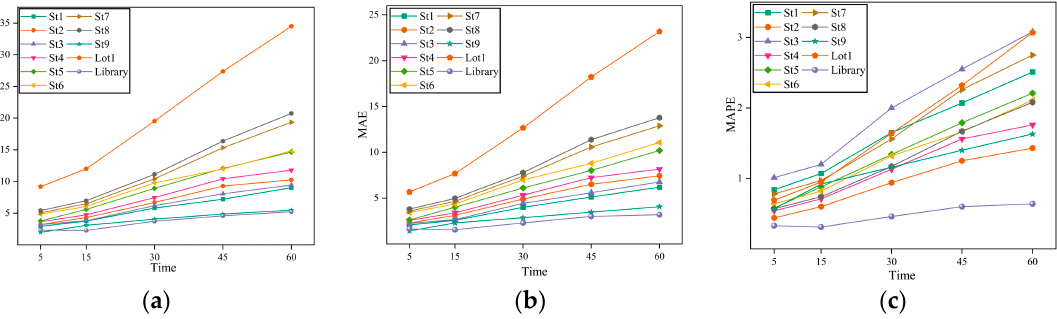
Figure 9. Comparison between the DWT-ConvGRU-BRC prediction and actual values at 5, 15, 30, 45, and 60 min. ( a ) St5 parking lot; ( b ) St7 parking lot; ( c ) Lot1 parking lot. Table 1. Performance evaluation in terms of the MAE, RMSE, and MAPE.